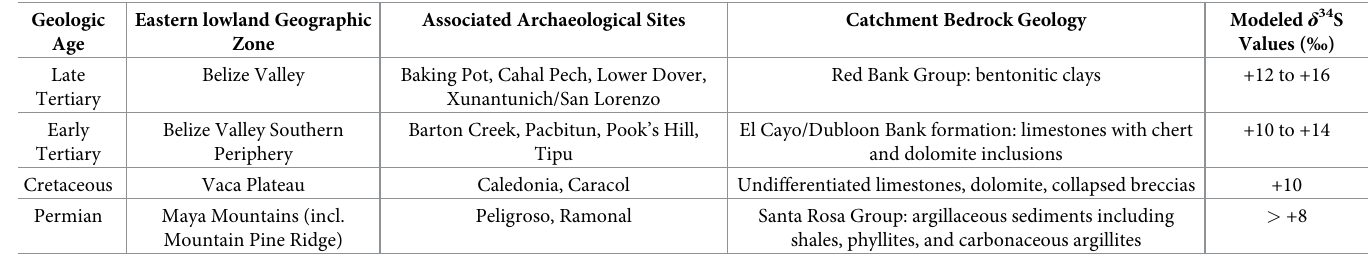
Values (‰) +10 to +14 > +8